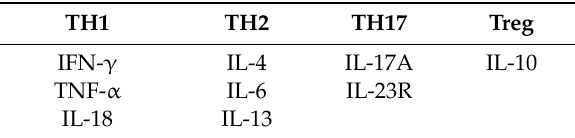
Table 4. The cytokine expression evaluated by RT-PCR, divided into respective immune responses of the T helper lymphocyte populations. TH1 TH2 TH17 Treg IFN- γ IL-4 IL-17A IL-10 TNF- α IL-6 IL-23R IL-18